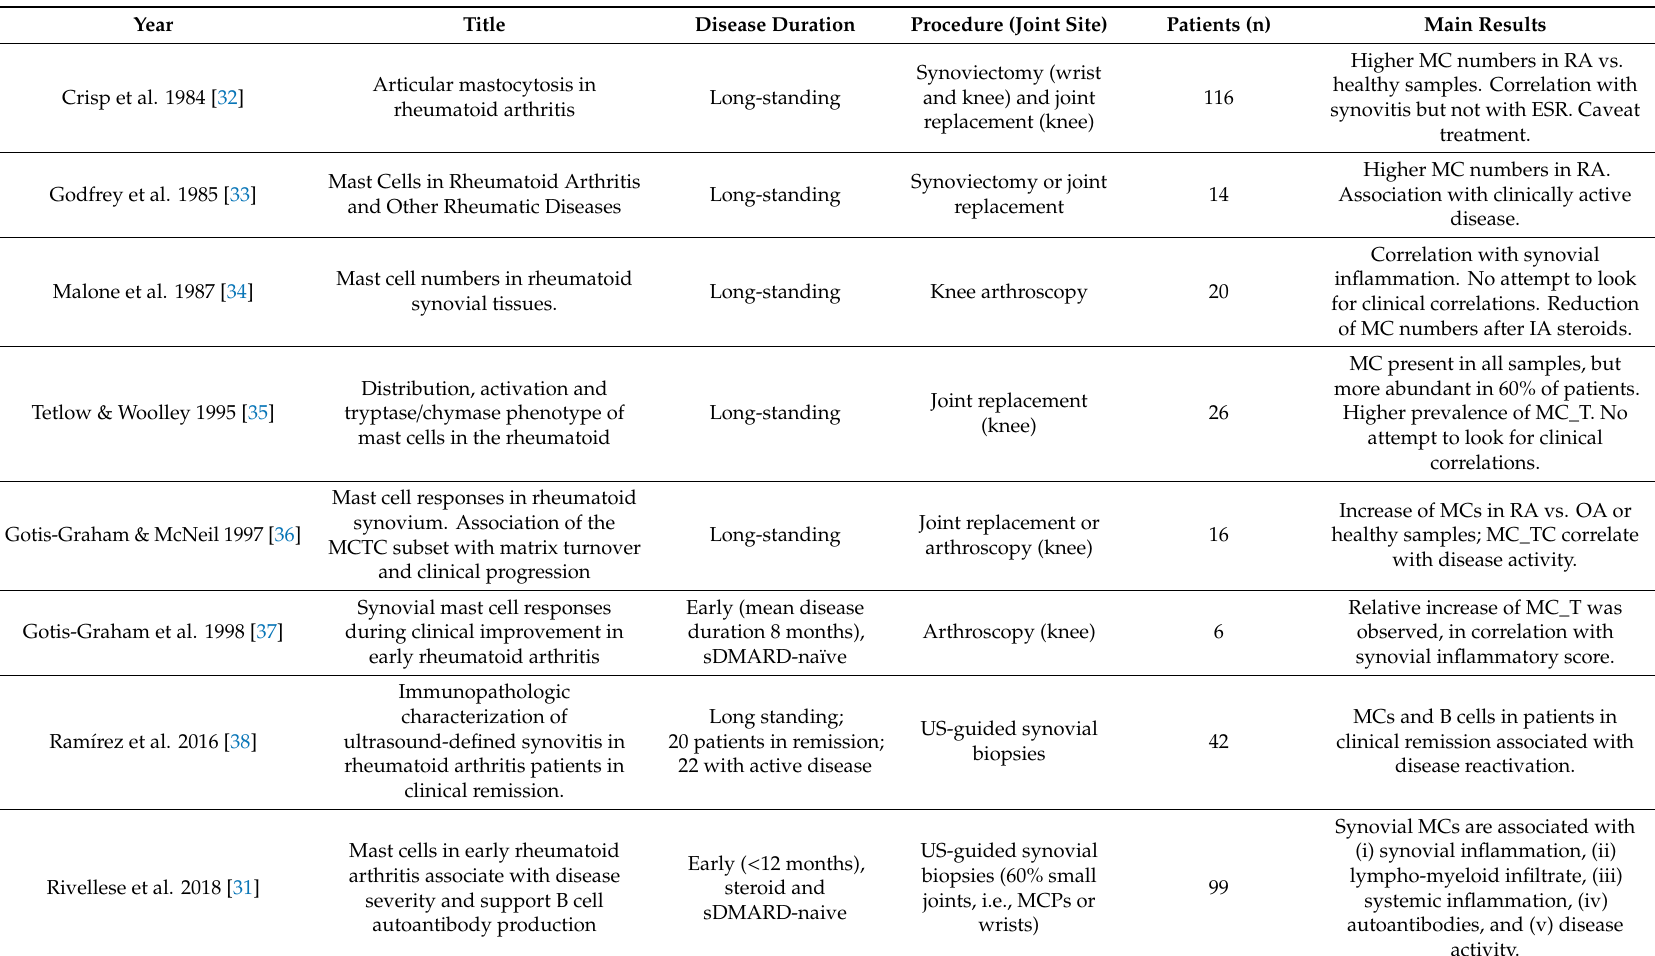
Table 1. Summary of the studies analyzing synovial MCs in RA